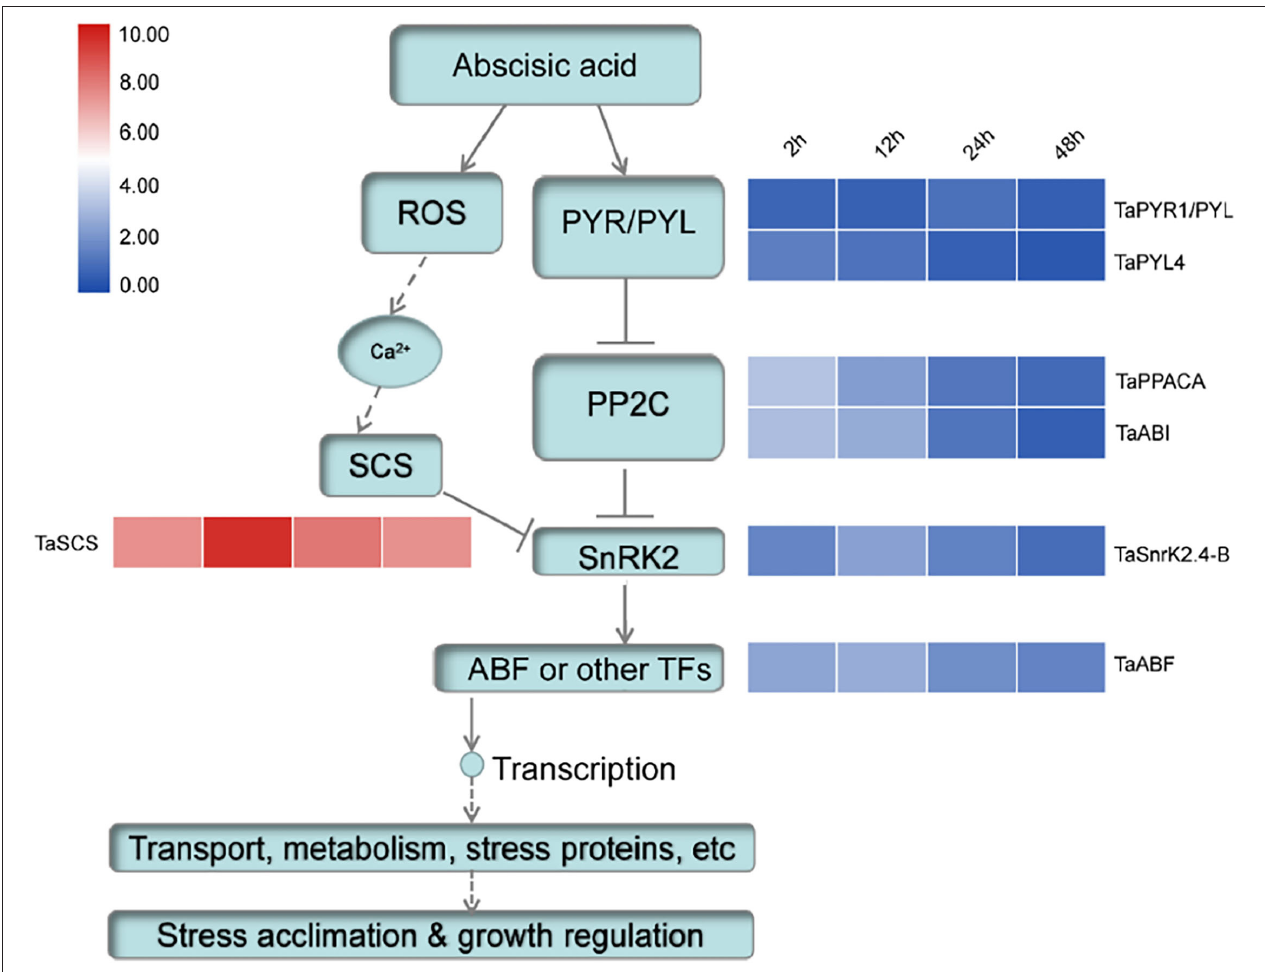
FIGURE 7 | Expression level detected by qRT-PCR of key point genes involving ABA pathway in